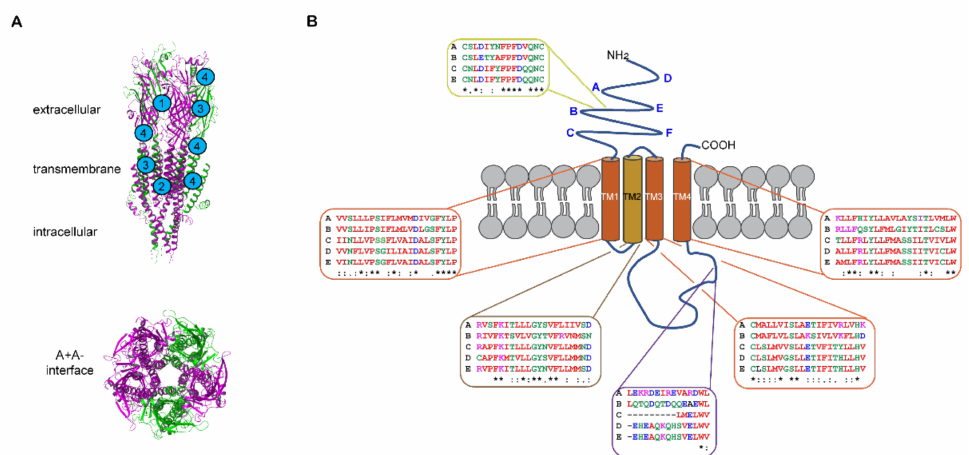
Figure 2. Architecture of 5-HT 3 receptors. ( A ) Homology model of the human 5-HT 3 AC receptor assembled in the A 3 C 2 stoichiometry showing membrane spanning side and central pore views (maroon = A and green = C subunits). Examples of proposed binding sites for competitive, non- competitive, and dual acting antagonists (labeled 1–3), and allosteric modulators (indicated with 4). The model is from [153] where A and C subunits were created from the mouse 5-HT 3 A recep- tor structure [139] as they have 95% and 58% homology with the mouse A subunit, respectively. ( B ) Schematic diagram of a single 5-HT 3 receptor subunit showing the different domains and extracel- lular A–F loops (bolded in blue). A Clustal omega alignment was done on the human 5-HT 3 receptor subunit protein sequences obtained from NCBI [154] and this is shown for the Cys-loop (yellow box), membrane-spanning α -helices of transmembrane domains 1 to 4 (TM1-TM4) (brown and orange boxes), the triple R region of the intracellular loop involved in pentamer assembly [155] and the low conductance associated with A homomer receptors [156] (purple box). Accession numbers: NP_000860 (A subunit), NP_006019 (B subunit), NP_570126 (C subunit), NP_001157118 (D subunit), and NP_872395 (E subunit). Identical residues are indicated with an asterisk (*), conserved residues with a colon (:), and semi-conserved residues with a full stop (.). Image drawn in Adobe Illustrator. The large intracellular loop between transmembrane domains 3 and 4 contains an